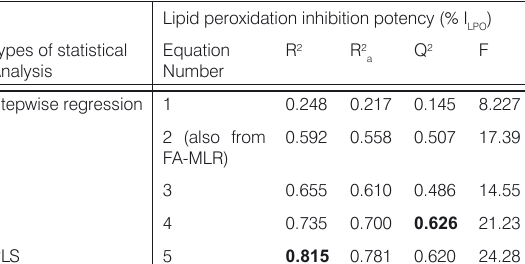
Table 5. Statistical qualities of the equations in lipid peroxidation inhibition potency of